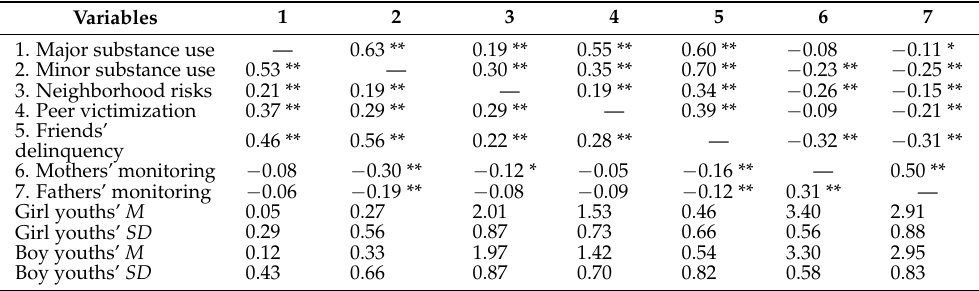
Table 2. Means, standard deviations, and bivariate correlations for boys (above the diagonal) and girls (below the diagonal).